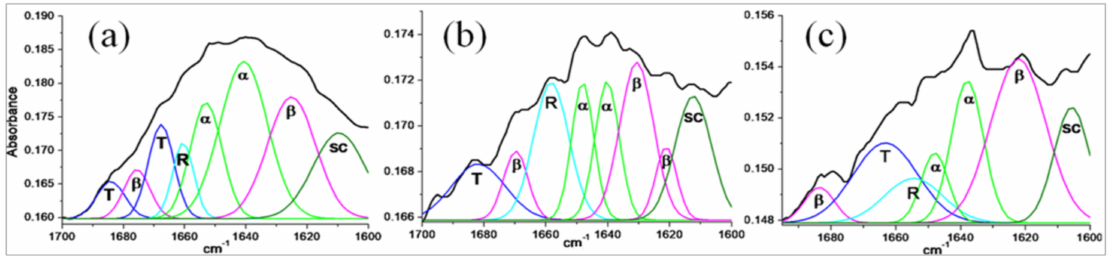
Figure 5. Secondary structure analysis from FT-IR spectra: gliadin ( a ); 11.8 kD isolated fragment ( b ); and 13.8 kD isolated fragment ( c